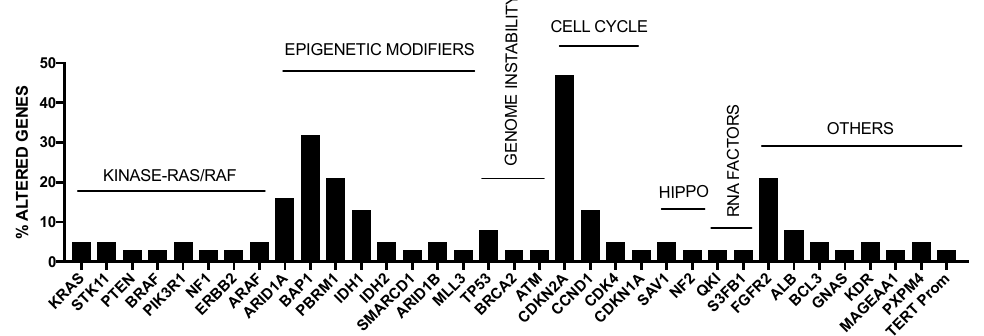
Figure 2. Frequent somatic alterations observed in cholangiocarcinoma (CCA). The data were reported by the TCGA in 38 CCA patients [29]. The altered genes were subdivided into different groups according to their function.